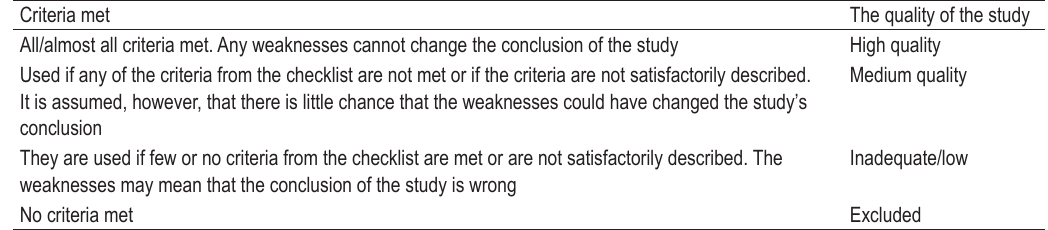
TABLE 3. Overview criteria met and the quality of the study Criteria